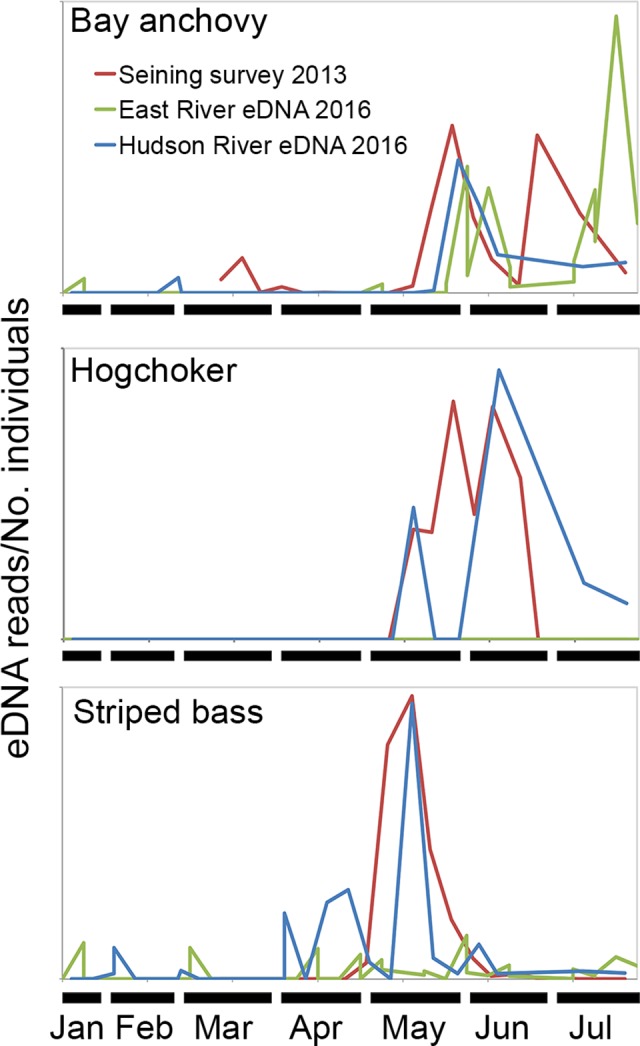
eDNA reads and seining survey abundance by date.Scales of eDNA reads and no. individuals differ between species. Number of individuals from 2013 Long River Survey trawls conducted between March 13 and July 27 at the southern tip of Manhattan, approximately 10 km by water from both study sites [28]. For bay anchovy and hogchoker, graph represents number of yearling and older individuals; for striped bass, graph represents number of eggs collected in the entire estuary as a proxy for migratory adult individuals, as the survey seining equipment does not capture mature striped bass.